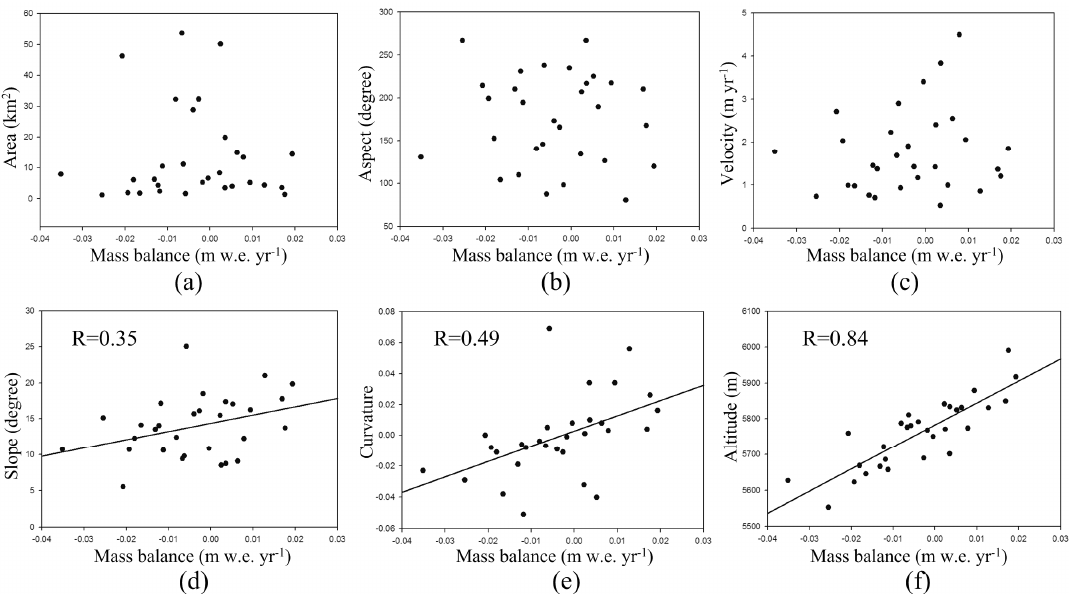
Figure 8. Correlations between glacier mass balance and individual morphometric factors from the